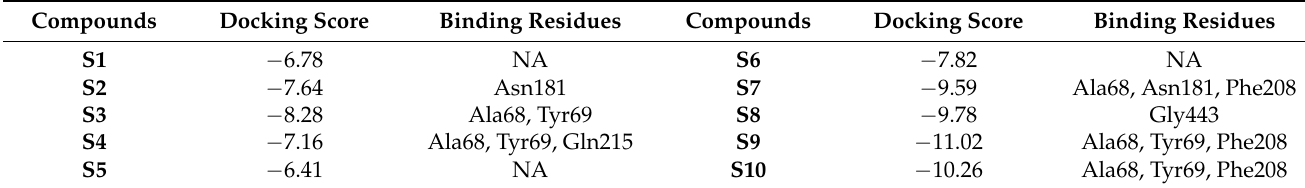
Table 1. The Glide scores (Kcal/mol) and H-bond against 2Z5X. NA stands for not available.